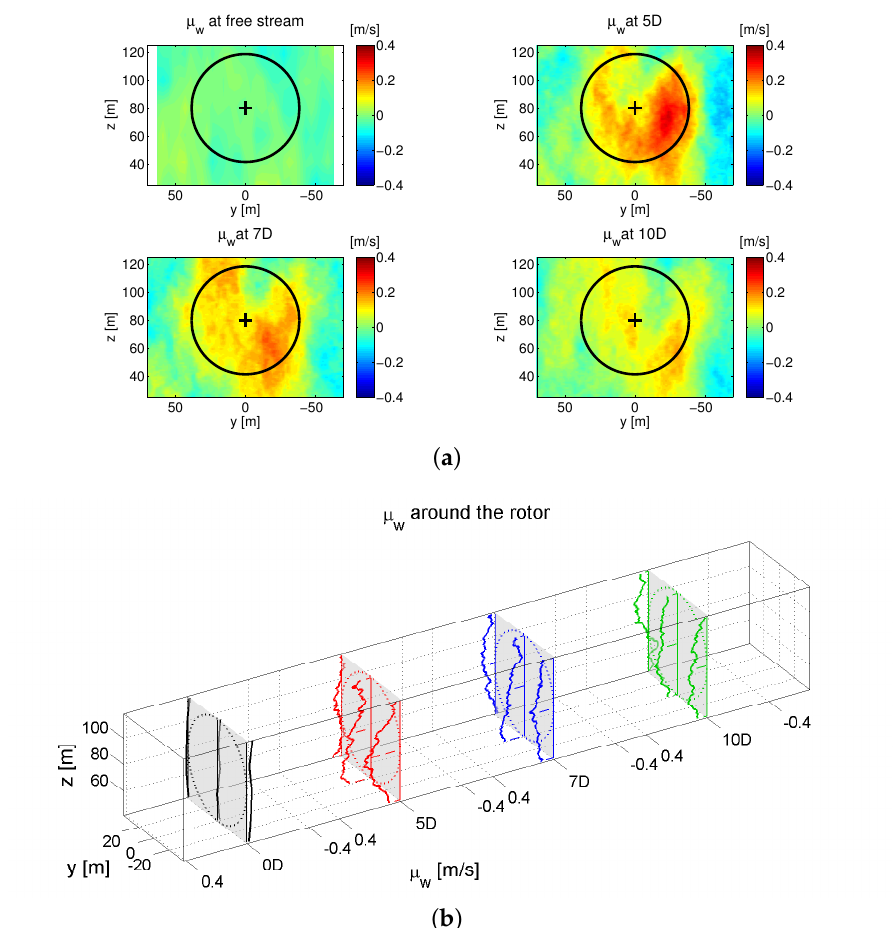
Figure 9. Spatial variation µ w in the waked field versus the free-stream field: ( a ) variation of µ w in vertical planes; and ( b ) profile of µ w